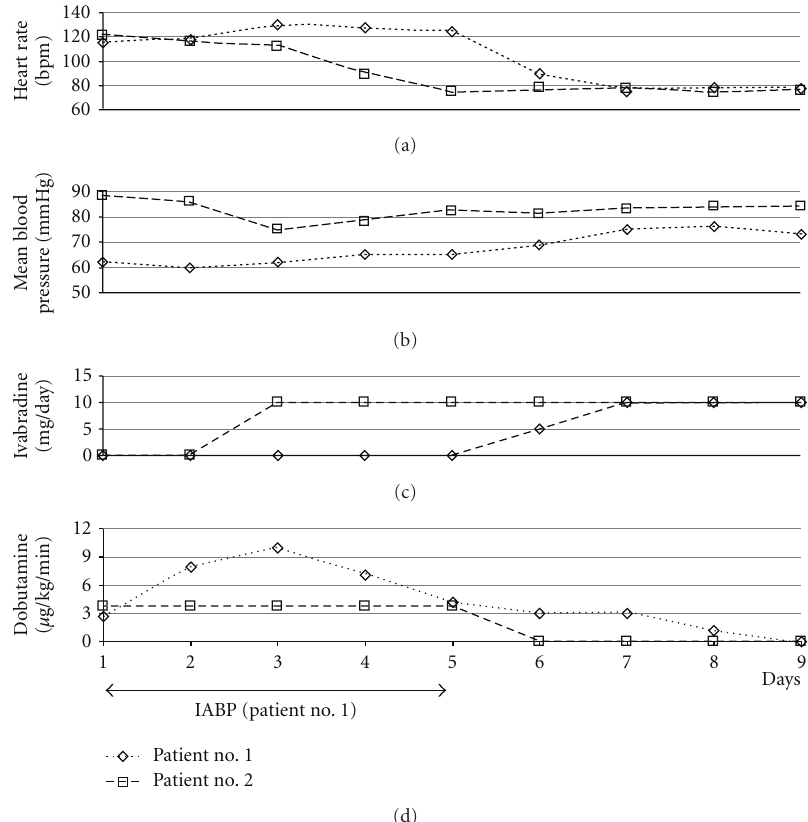
Figure 1: Therapy and hemodynamic parameters of patient no. 1 and no. 2 throughout the first nine days of intensive care treatment. IABP: intra-aortic balloon counterpulsation.